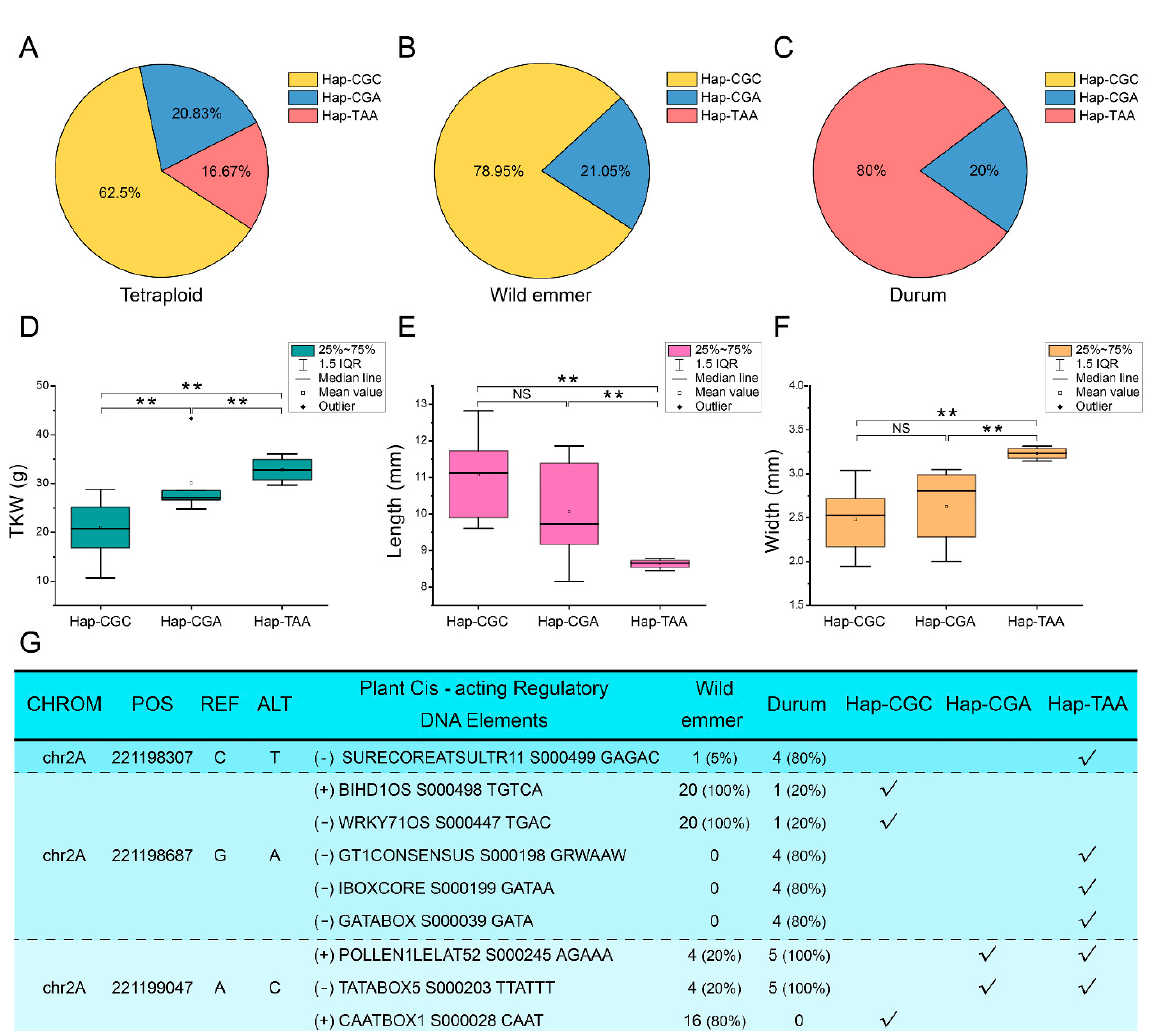
Figure 6. Haplotype-based phenotyping analysis. ( A – C ) Distribution of three haplotypes (Hap-CGC, Hap-CGA and Hap-TAA) in different tetraploid wheat populations. Three haplotypes located in the promoter region of Ta2A_ATG8a were found and their distribution in different tetraploid wheat populations was diverse. ( D – F ) Haplotype-based grain character analysis. The association between three haplotypes and grain characters was analyzed. Abnormal value of TKW, corresponding to HAP-CGA, was not considered in testing for significant difference test. ** p < 0.01. ( G ) Changes of cis -acting elements resulted from SPNs in the promoter region of Ta2A_ATG8a and their distribution in different populations.